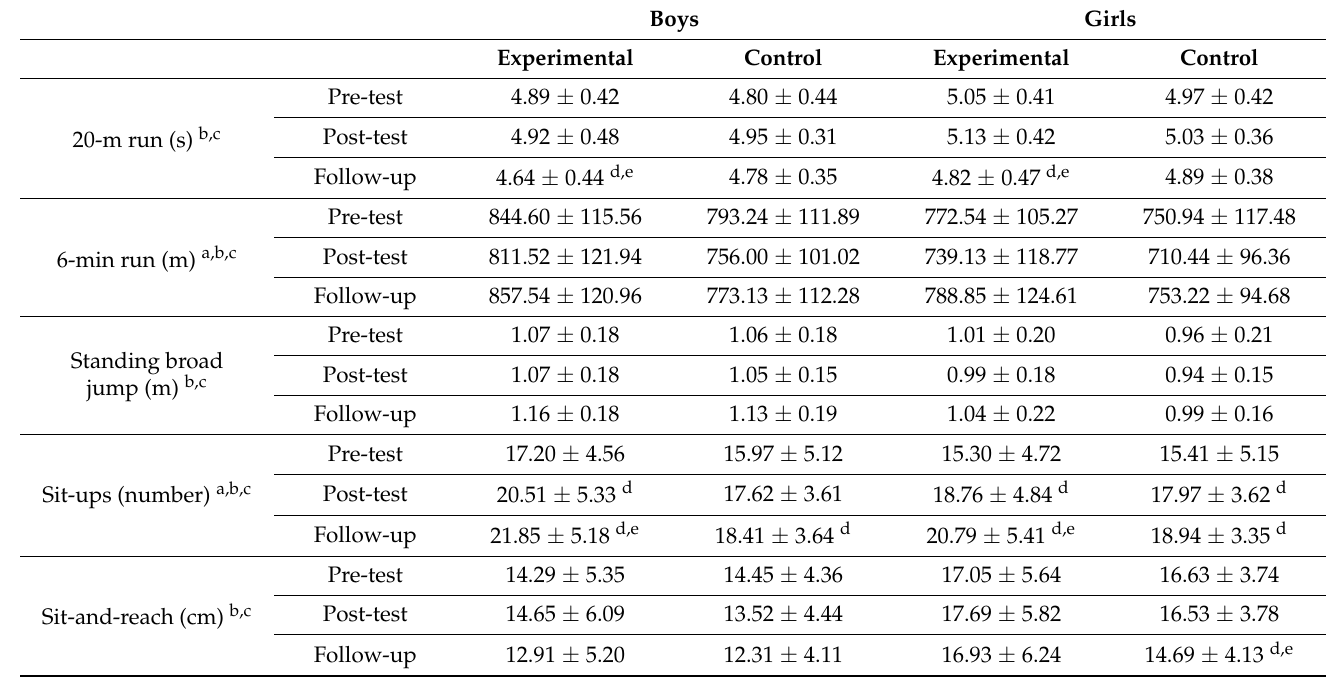
Table 1. Differences between the experimental and control groups in the fitness test (5 items). Boys